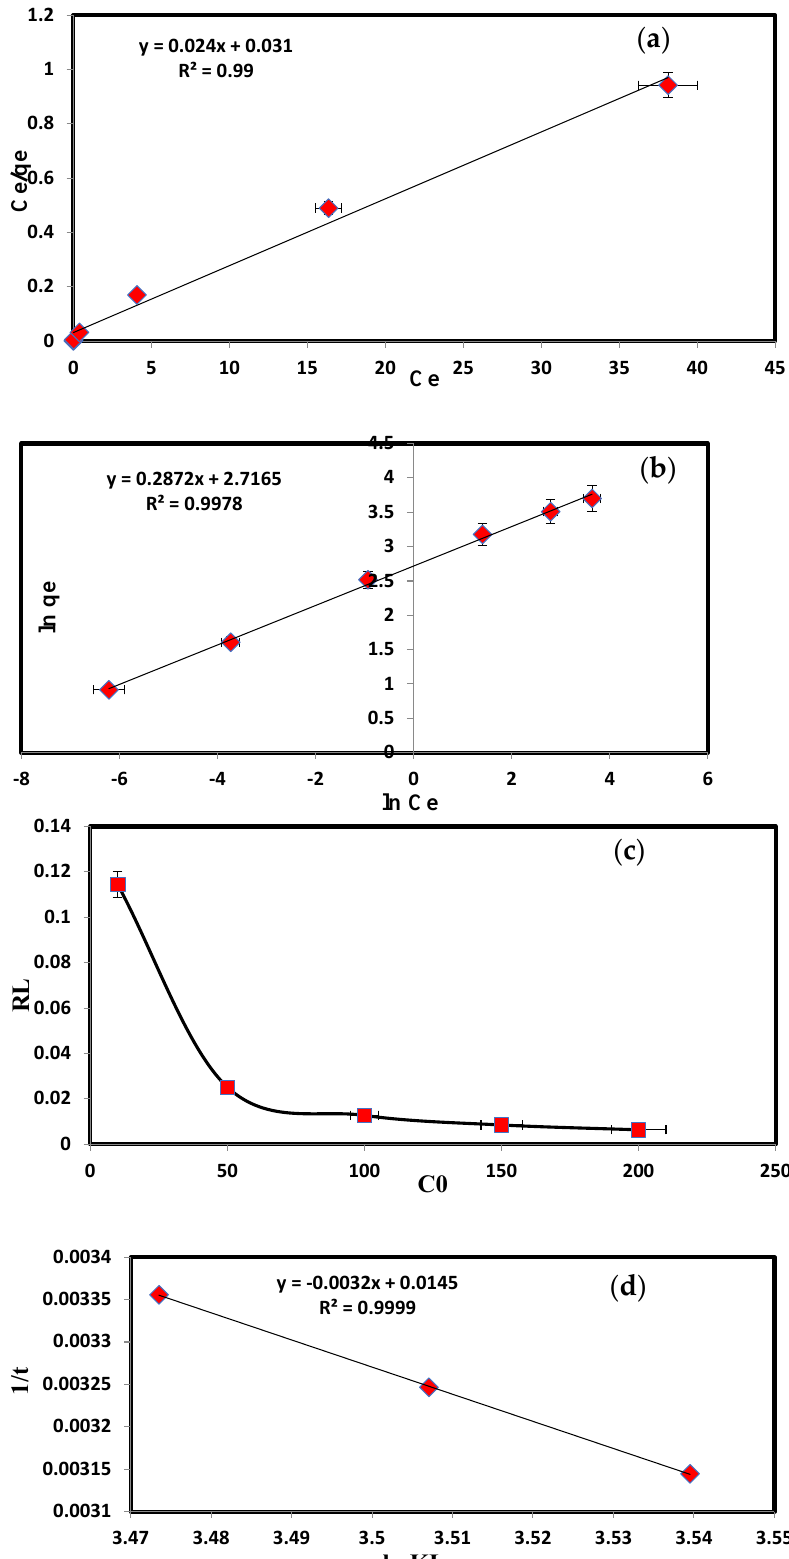
Figure 3. MD kinetic plots on PbO@MgZnO at different initial MD concentrations.